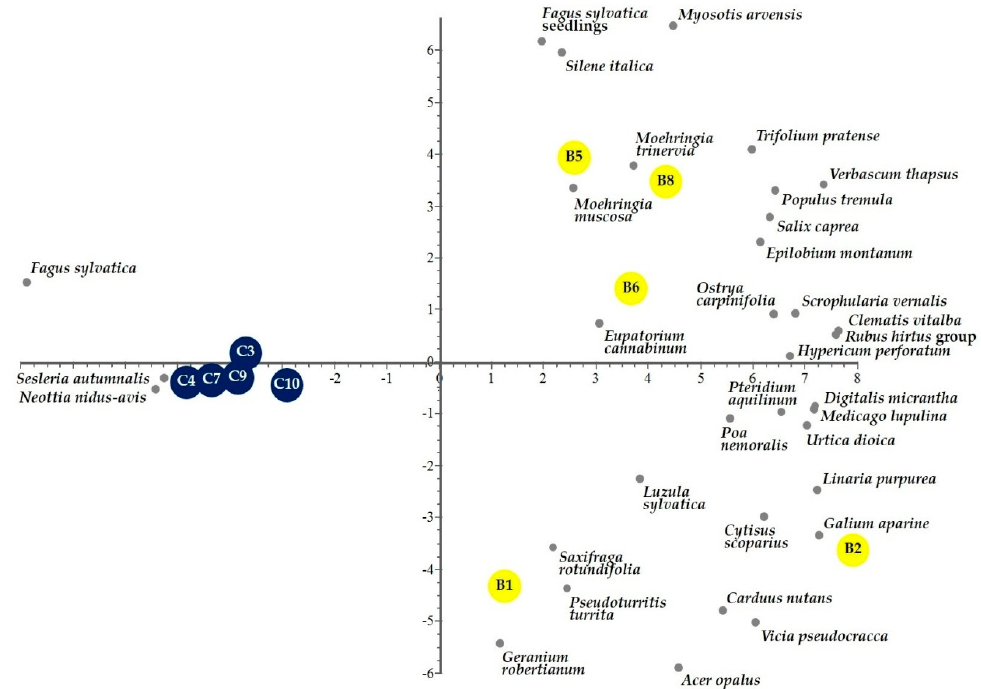
Figure 5. Biplot of the Principal Component Analysis of burned (yellow circles) and control (blue circles) plots with the indication of vascular plant species (grey circles) in the first two principal components space. Forests 2020 , 11 , x FOR PEER